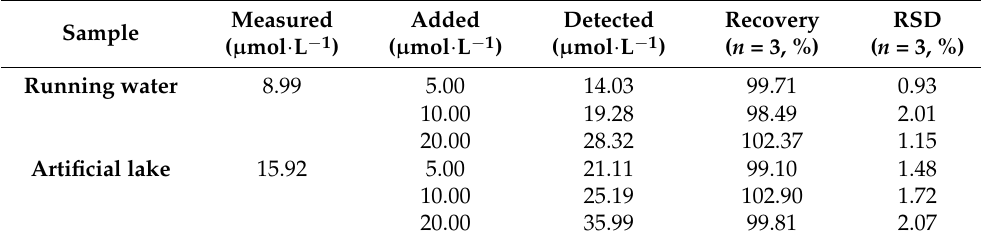
Table 1. The detail data for Cu 2+ detection in real water